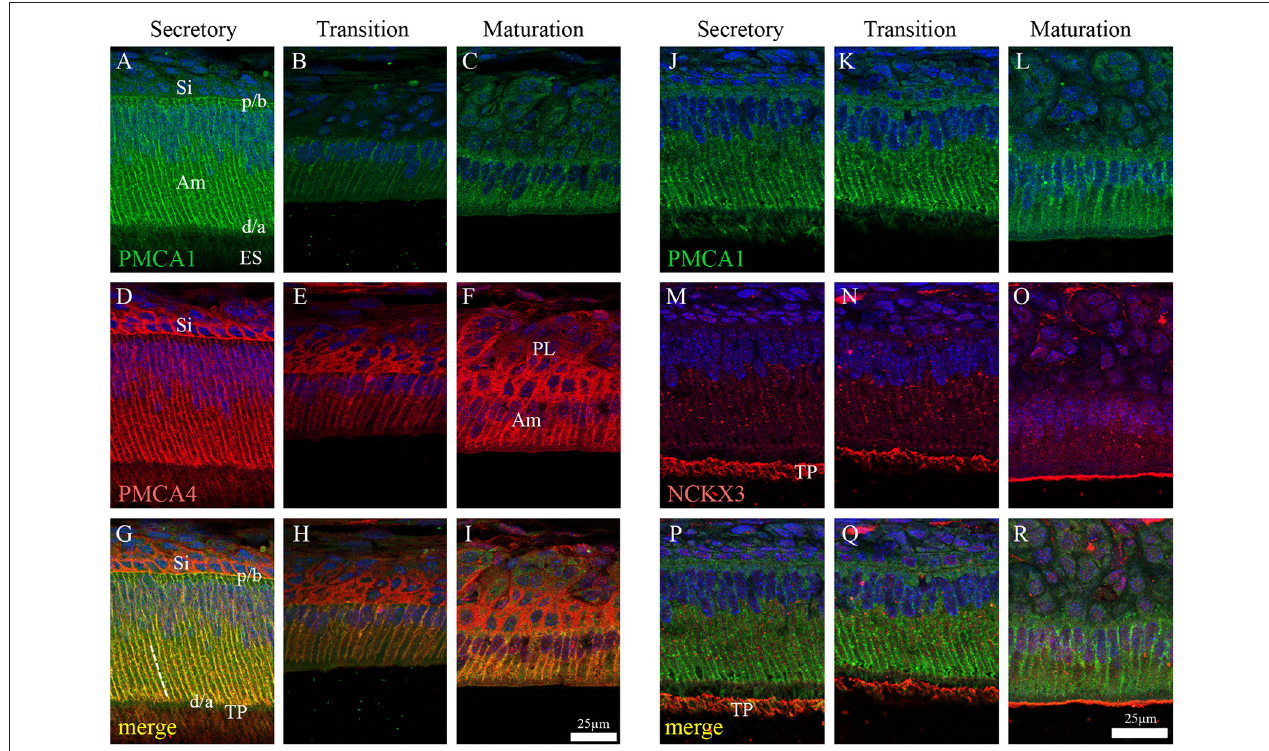
FIGURE 3 | Immunofluorescence analysis of PMCA1, PMCA4, and NCKX3 in 9-day-old mouse mandibular incisors. Columns from left to right show secretory-stage (A,D,G,J,M,P) , transition-stage (B,E,H,K,N,Q) and maturation-stage (C,F,I,L,O,R) ameloblasts; while rows show immunoreactivity for PMCA1 (green; A–C and J–L ), PMCA4 (red; D–F ) and NCKX3 (red; M–O ). Merged images are also shown for each column ( A,D merged to G ; B,E merged to H ; C,F merged to I ; J,M merged to P ; K,N merged to Q ; and L and O merged to R ). Am, Ameloblasts; ES, enamel space; Si, stratum intermediu (TP; secretory ameloblasts only), Tomes’ processes and (PL, maturation ameloblasts only), papillary layer. The proximal/basal poles (p/b) and distal/apical poles (d/a) of ameloblast cells are identified, as are the lateral membranes of ameloblasts (broken while line in G ). Scale for (A–I) shown in (I) ; and scale for (J–R) shown in R